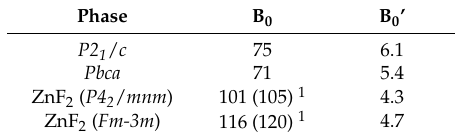
Table 2. The bulk modulus in GPa (B 0 ), and its derivative (B 0 ’) calculated for CuF 2 phases. Results obtained for the rutile ( P4 2 / mnm ) and fluorite ( Fm-3m ) structures of ZnF 2 are shown for comparison. Phase